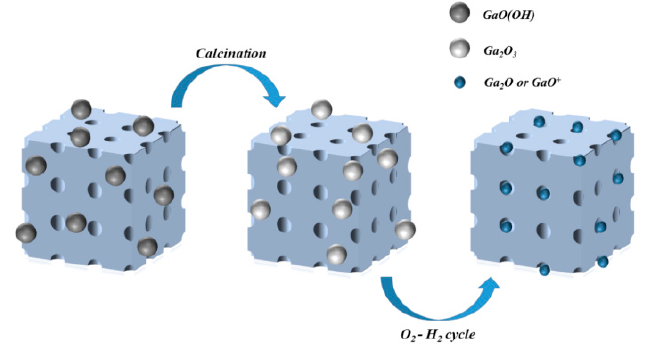
Figure 3. Changes in Ga species during pre-treatment.